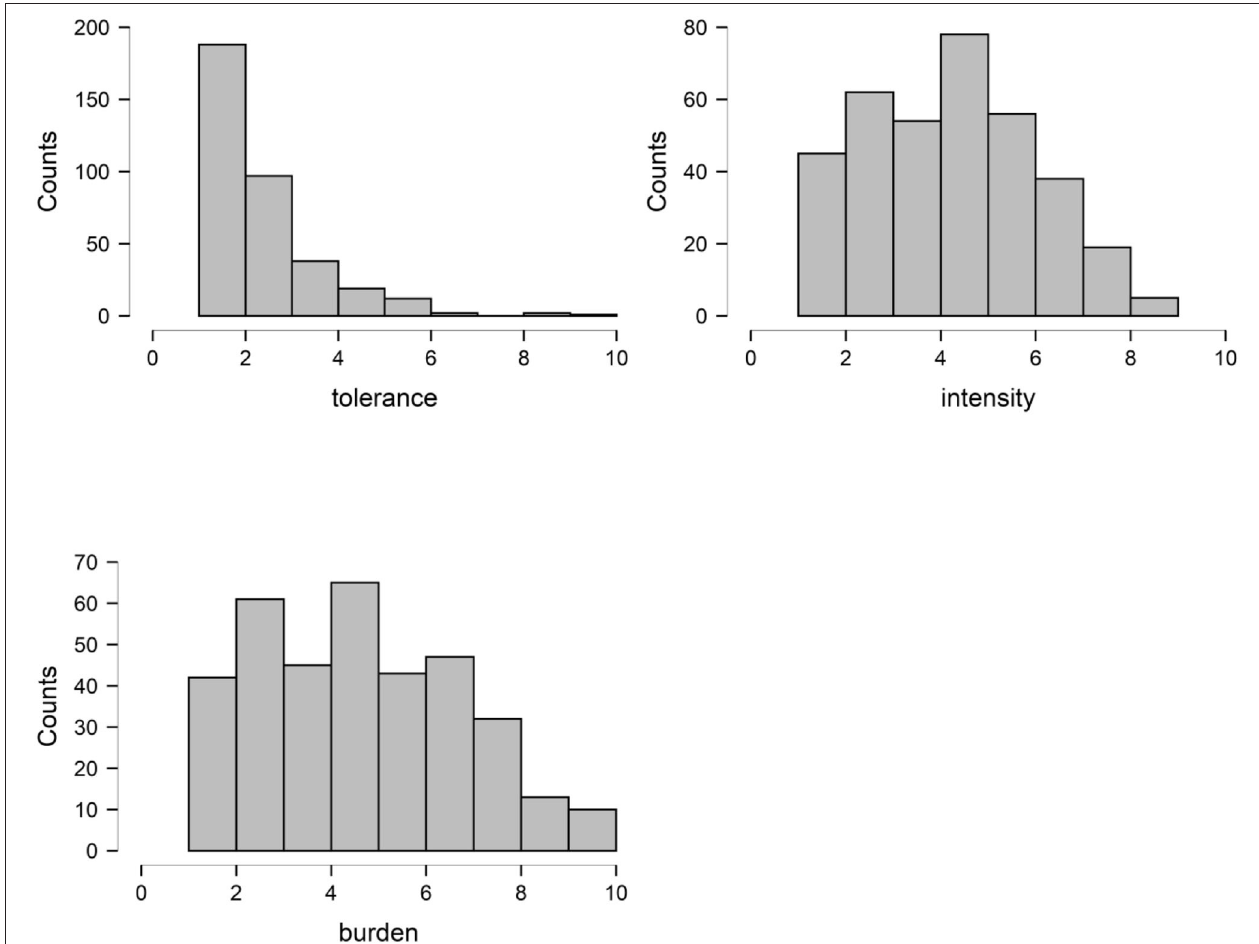
FIGURE 1 | The distributions of intensity, burden, and tolerable dizziness intensity.